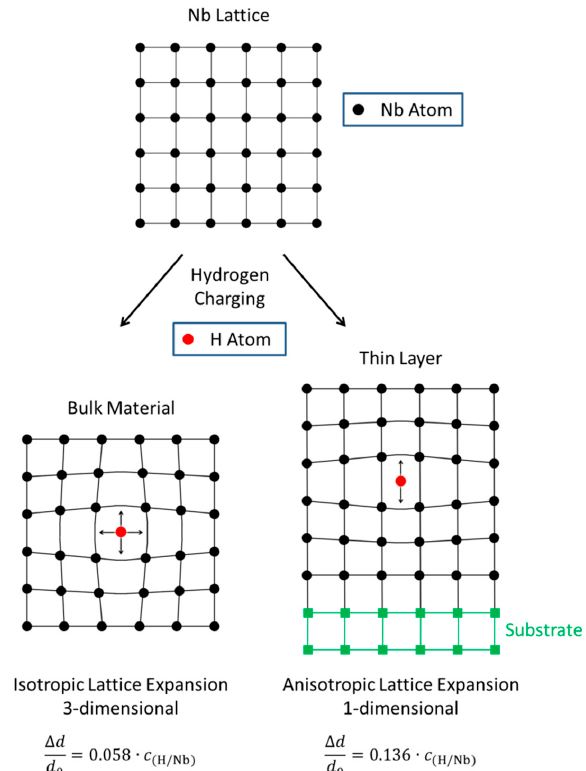
Figure 1. Hydrogen ‐ induced three ‐ dimensional isotropic expansion of the host lattice (bulk) versus Figure 1. Hydrogen-induced three-dimensional isotropic expansion of the host lattice (bulk) versus one ‐ dimensional lattice expansion (thin films). one-dimensional lattice expansion (thin